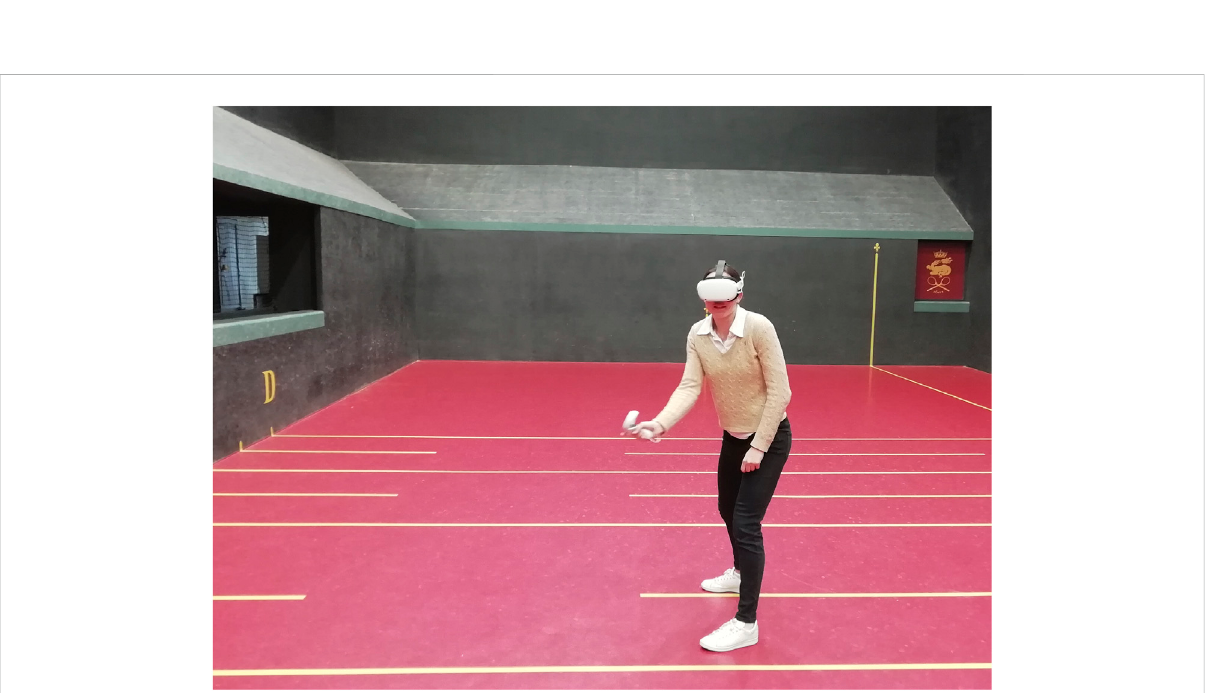
FIGURE 15 The female French number one testing the application on Oculus Quest 2, in the Fontainebleau court, France.